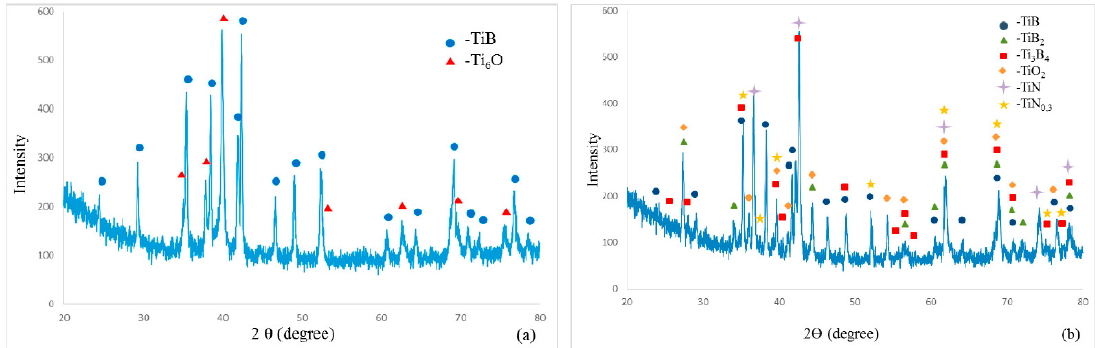
Figure 5. Specific sample mass increment at ( a ) 900 °C and ( b ) 1100 °C.